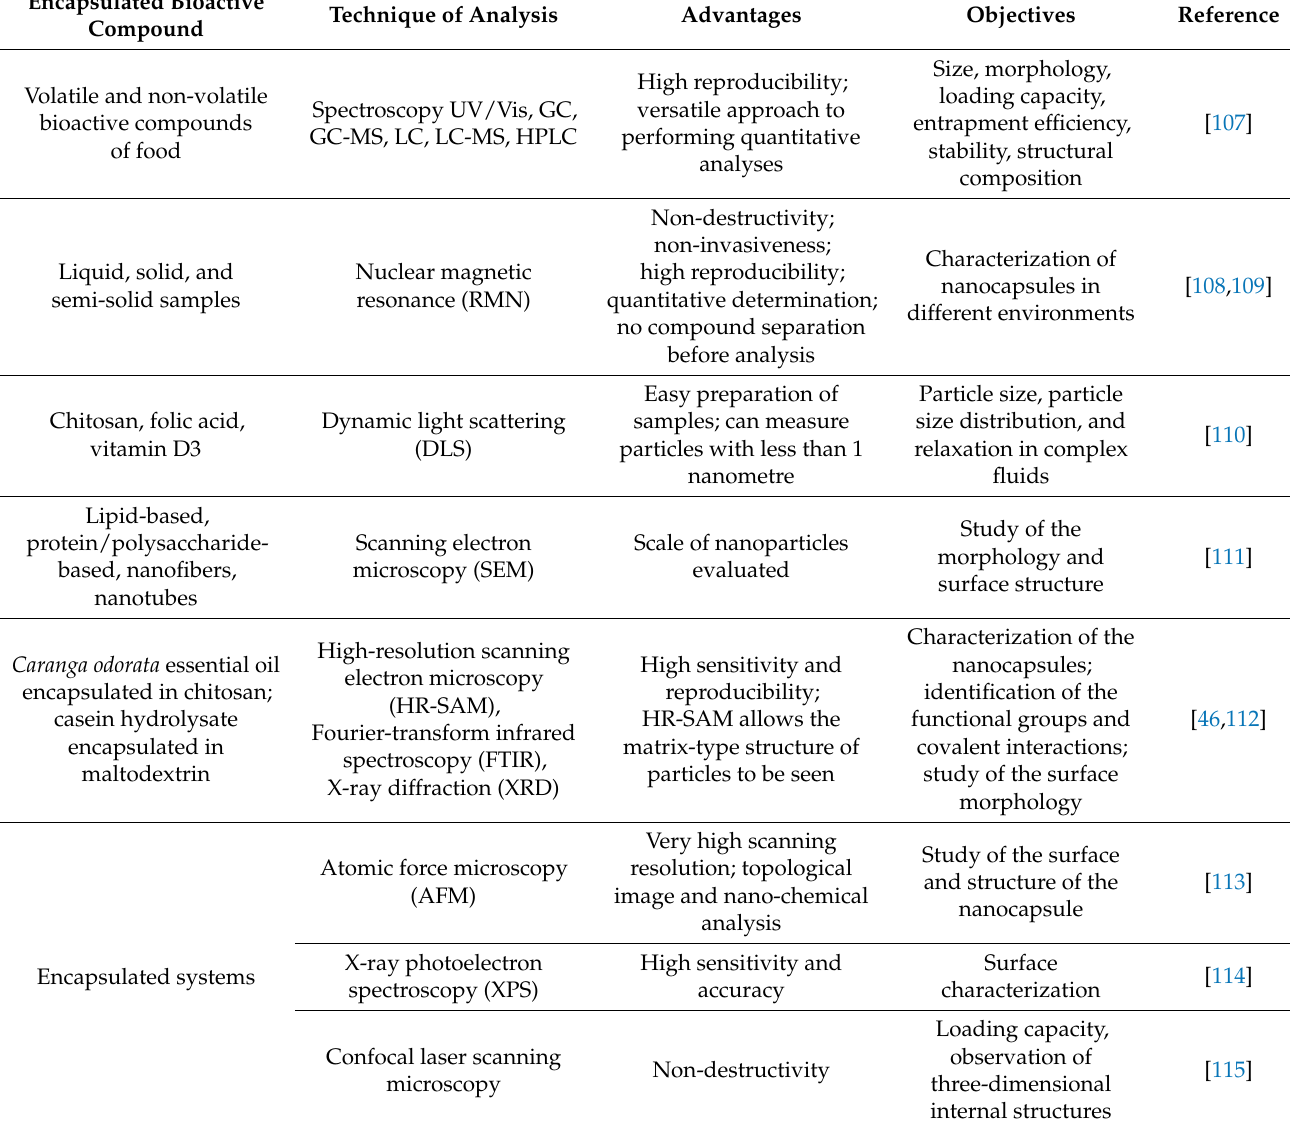
Table 5. Techniques to analyse the